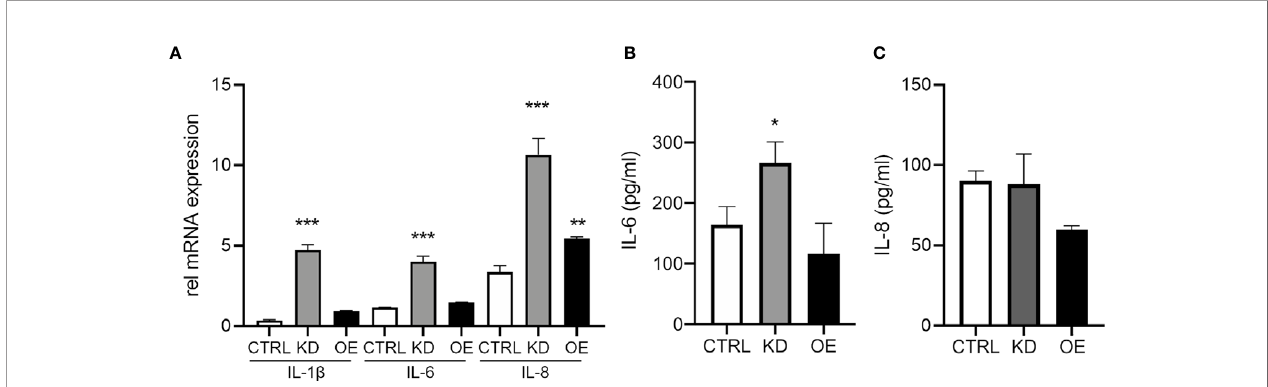
FIGURE 3 | ST6GAL1 knockdown increases IL-6 expression and secretion. (A) Relative mRNA transcript levels of IL-1 b , IL-6, and IL-8 in CTRL, ST6GAL1 KD, and ST6GAL1 OE HBECs. Analysis of IL-6 (B) and IL-8 (C) protein levels from supernatants of CTRL, ST6GAL1 KD, and ST6GAL1 OE HBECs using ELISA. CTRL,